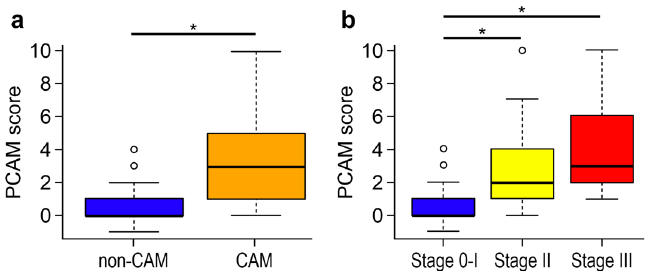
Figure 4. Comparing the PCAM scores. The PCAM score was calculated as the number of OTUs of the predominant bacteria in the non-CAM group subtracted from the number of OTUs of the predominant bacteria in the CAM group. The PCAM score was significantly higher in the CAM group ( P < 0.001) and more clearly correlated with staging than the Chao1 indices. * P < 0.05. CAM chorioamnionitis, OUT operational taxonomic unit, PCAM predictive